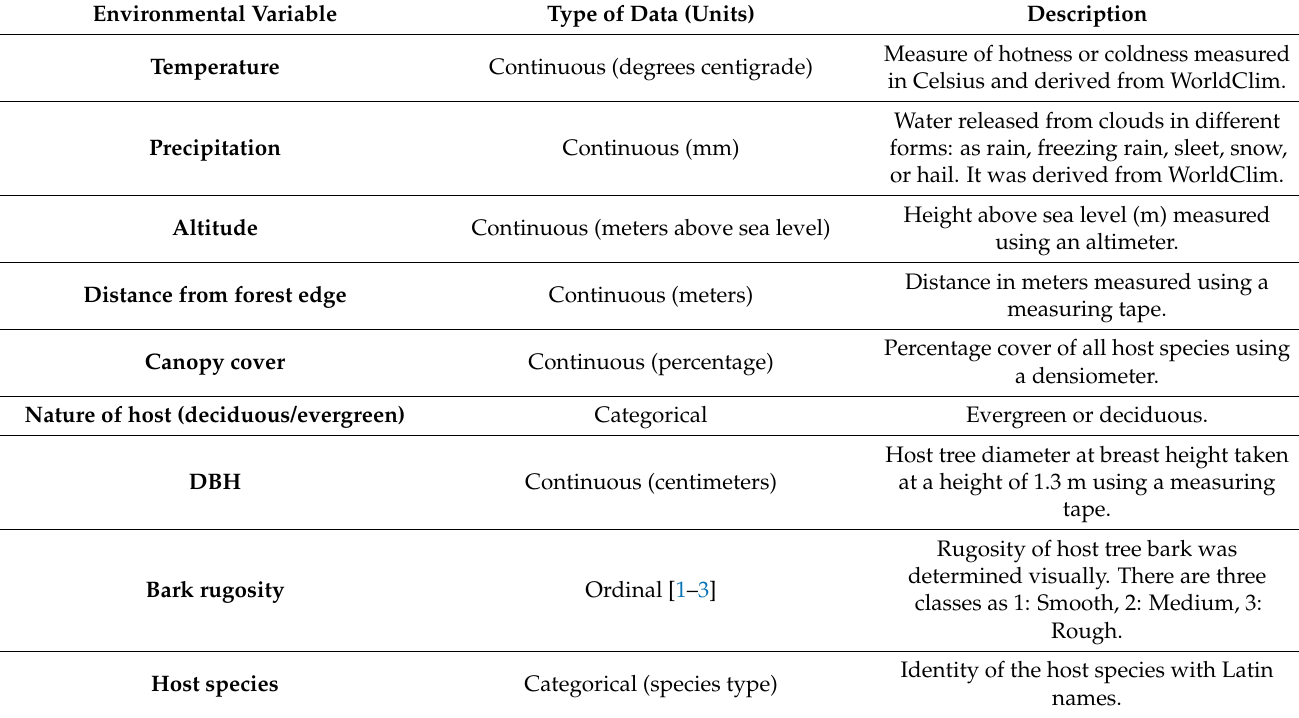
Table 1. List of the explanatory environmental variables recorded at the sites